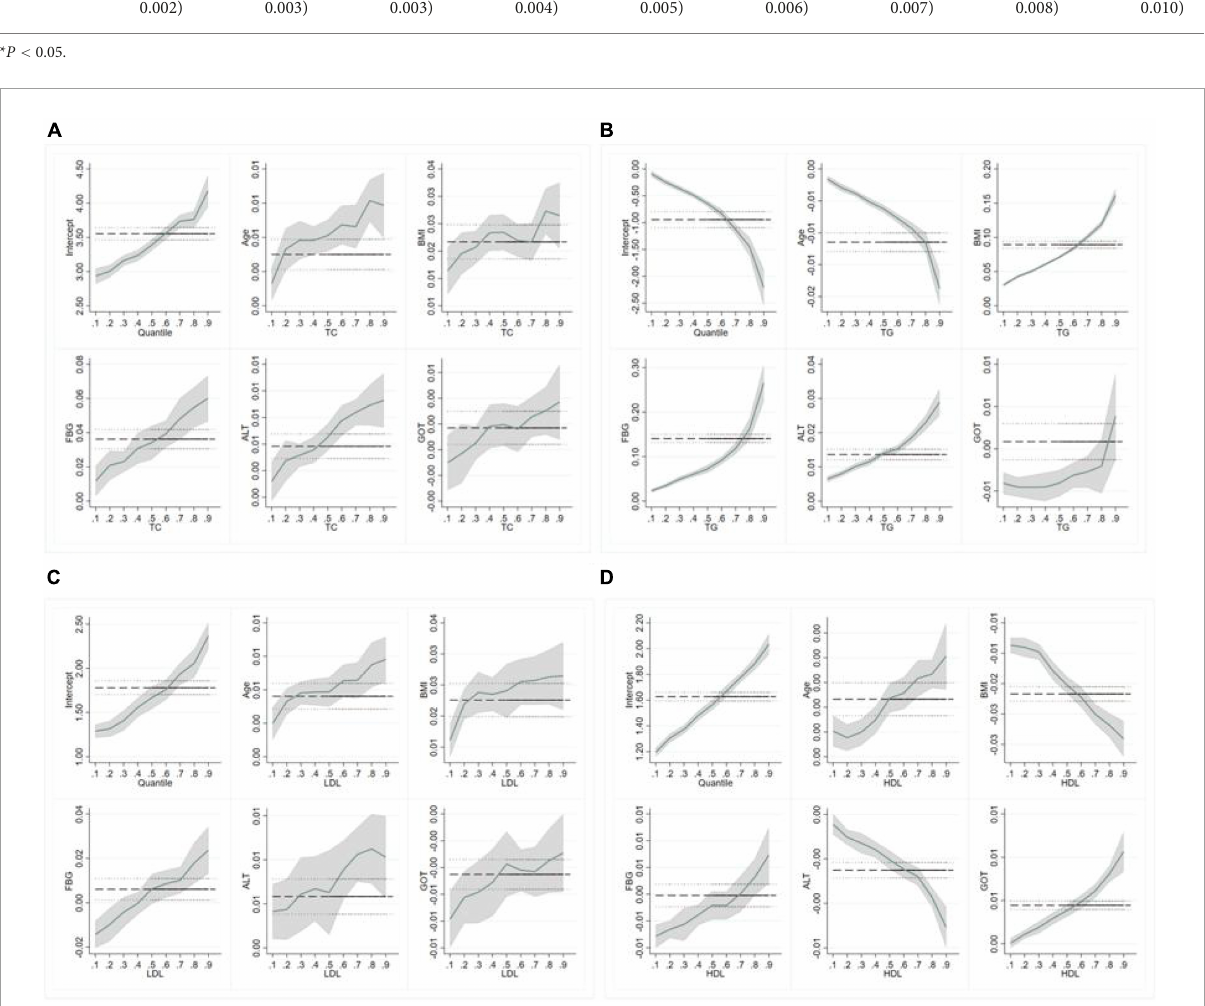
FIGURE3 Quantile regression (QR) results for lipid levels (males). (A–D) Represent the quantile regression results of TC, TG, LDL-c, and HDL-c levels,